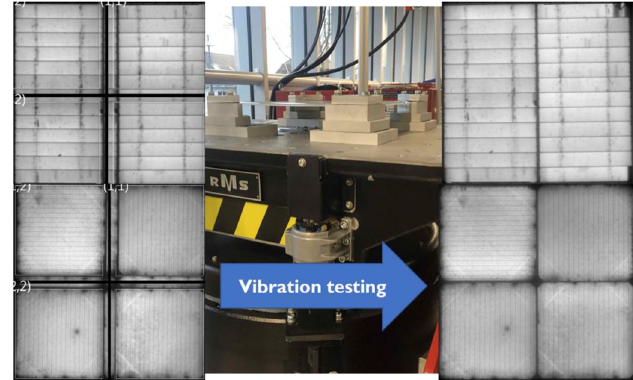
Fig. 9. Relative fi ll-factor degradation of a 1-cell GFRB laminate throughout thermal cycling.